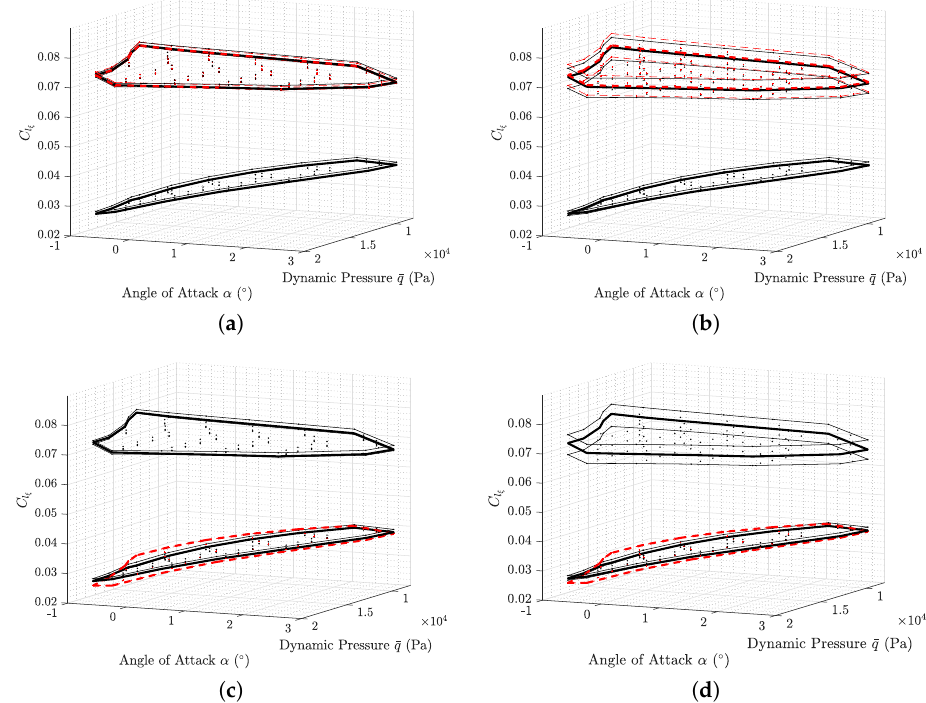
Figure 13. Aileron effectiveness model (black: identified model, red: prediction model): ( a ) rigid model 10% wingtip; ( b ) rigid model 20% wingtip; ( c ) flexible model 10% wingtip; and ( d ) flexible model 20%